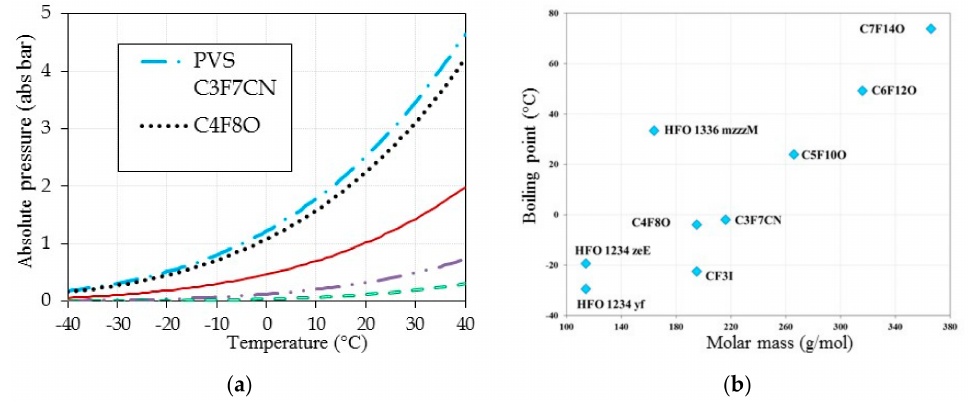
Figure 6. ( a ) Graph of the saturated vapor pressure as a function of the temperature of some complex fluorinated gases; ( b ) dependence of the boiling point on the molar mass of selected gas molecules [38].